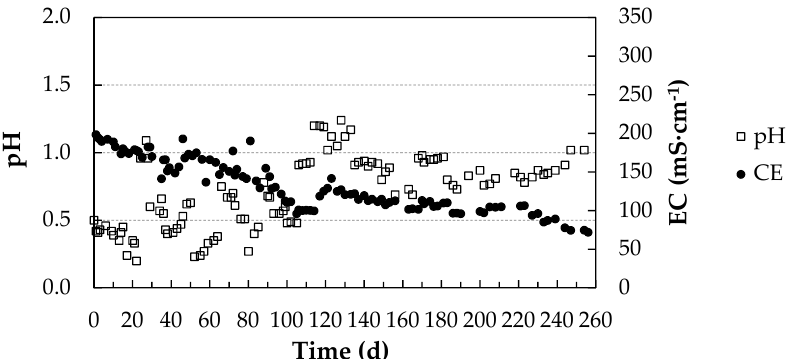
Figure 5. pH and EC values of the acidic solution during the experimental period at the poultry farm.3.1.2. Evolution of Total Ammoniacal Nitrogen (TAN) Captured in the Acidic Solution